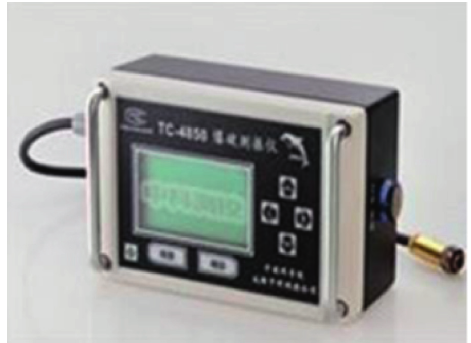
Figure 7: TC-4850 vibration acquisition